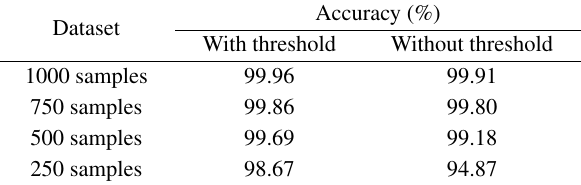
Fig. 6 Test accuracies under different capacities of datasets in Case 1. Table 1 Accuracy comparisons with/without threshold in different samples of limited labeled datasets in Case 1.